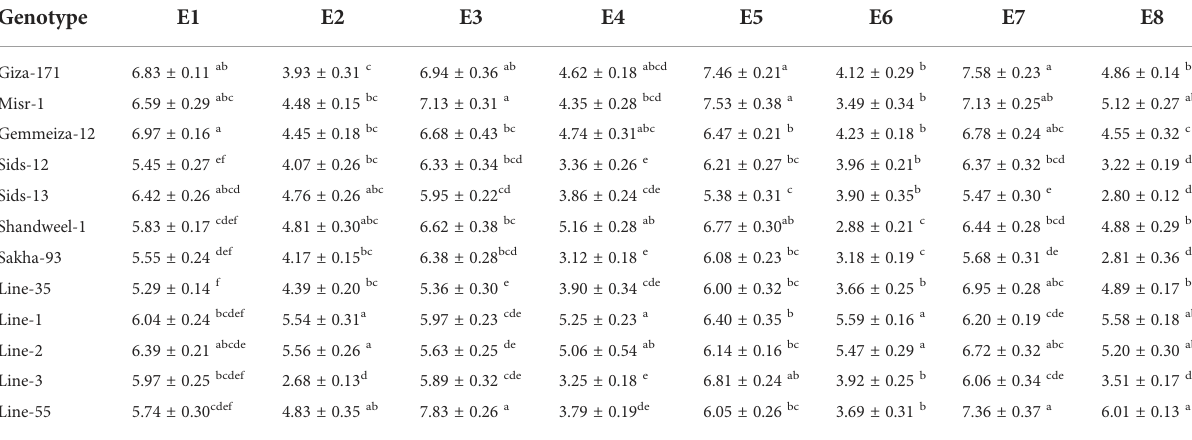
TABLE 8 Grain yield (t/ha) for twelve bread wheat genotypes in two locations (Kafer El-Hamam and Sakha) during two growing seasons in 2015- 2016 and 2016-2017 under timely and late sowing dates. Genotype E1